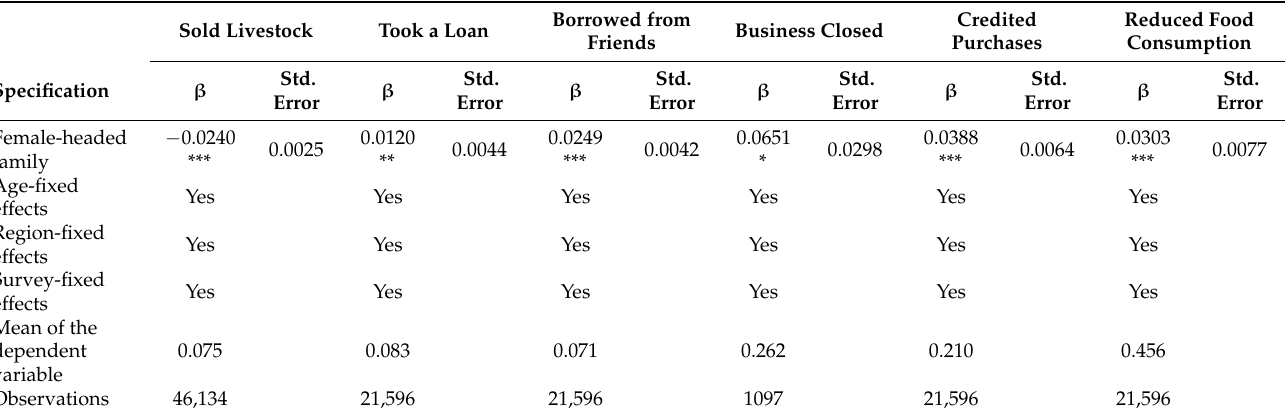
Table 3. Relationship between household structure and livelihoods (lost incomes or consumption) in